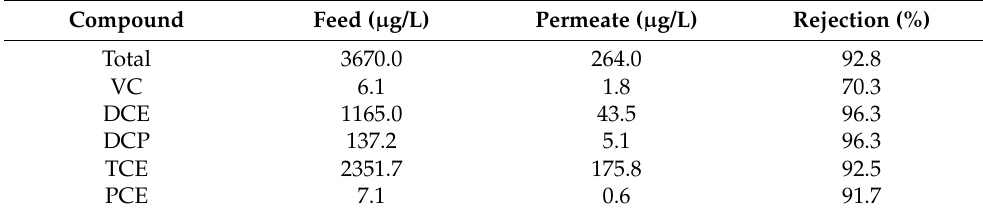
Table 9. GC–MS data of five main components detected for the 8th July samples.